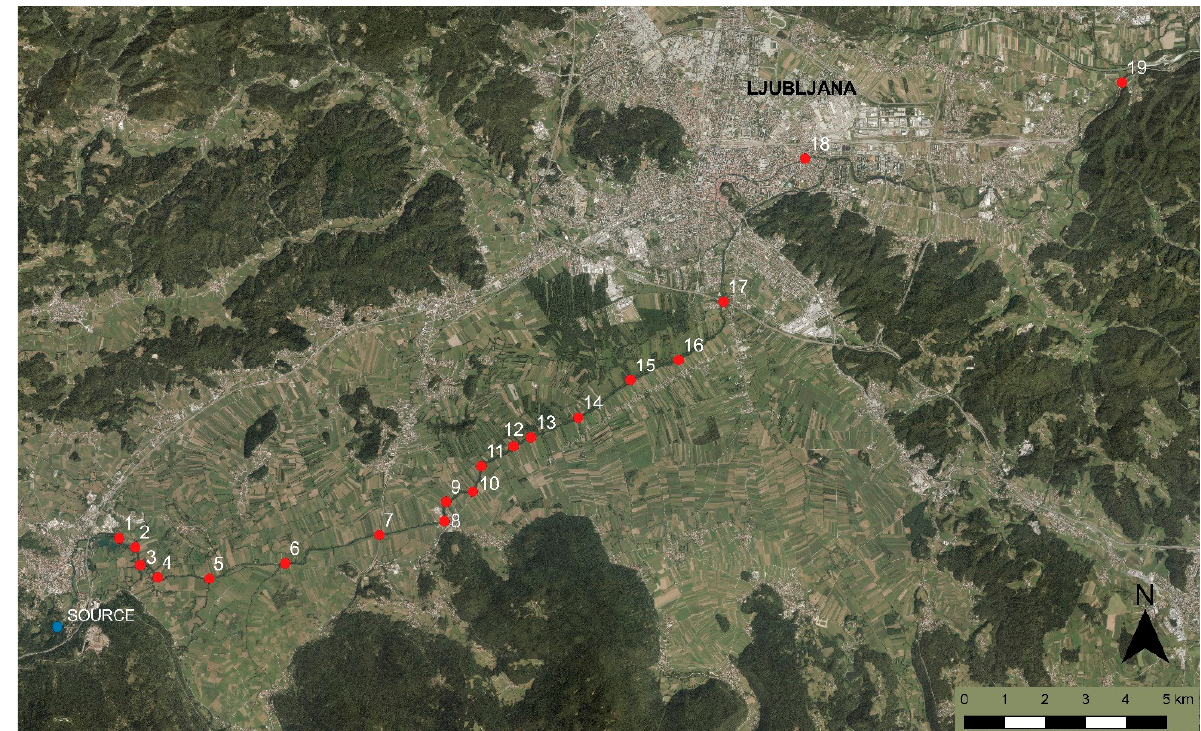
Figure 1. The spring of Ljubljanica River is marked with the blue circle on the map. The red squares and numbers from 1 to 19 indicate surveyed sections from its source near Vrhnika to the outflow river Sava (ARSO Geoportal: Atlas of the Environment).